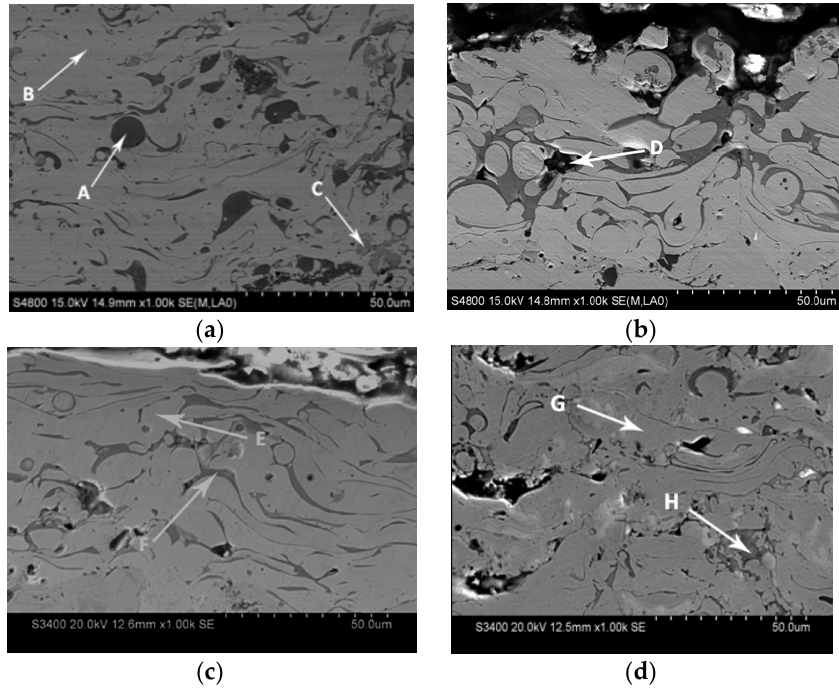
Figure 3. Microstructure of the coating: ( a ) 20TiB 2 ‐ NiCr; ( b ) 40TiB 2 ‐ NiCr; ( c ) 60TiB 2 ‐ NiCr; and ( d ) Cr 3 C 2 ‐ 25NiCr. Table 3. The chemical composition (at.%) in different regions.